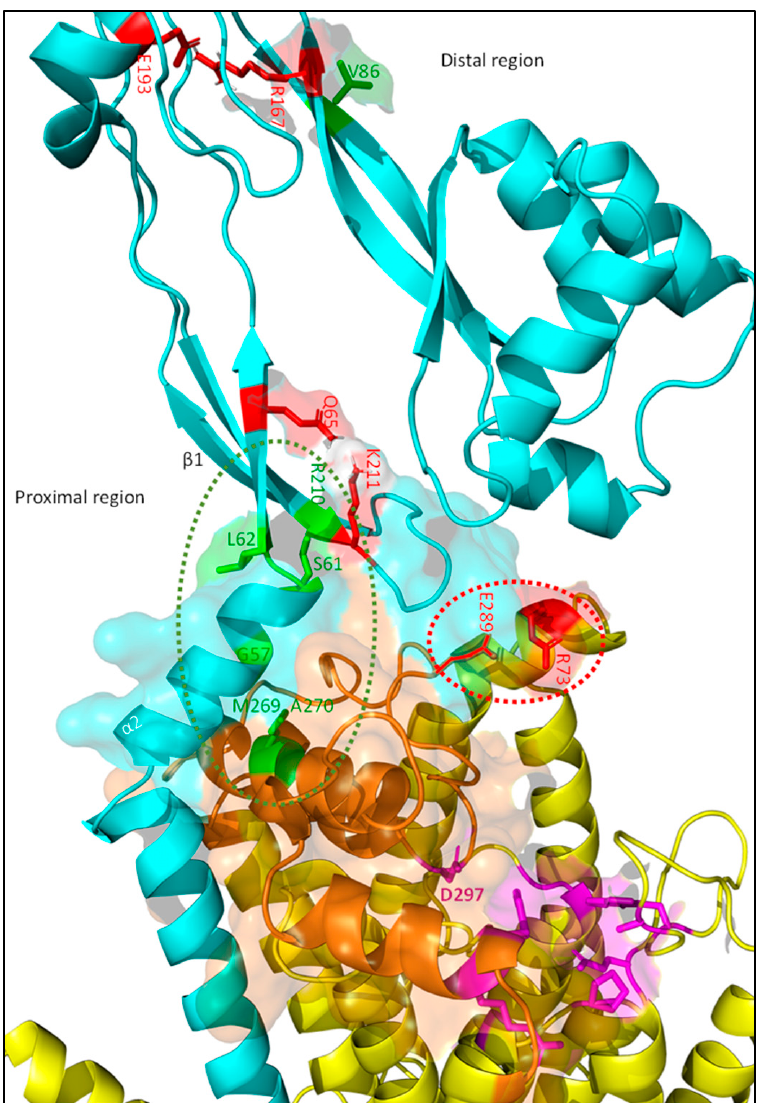
Figure 5. FtsI pedestal domain interaction with FtsW ECL4. FtsI (cyan) and FtsW (yellow) interact in the periplasm leading to the activation of FtsW. The membrane proximal part of the FtsI pedestal domain interacts with ECL4 of FtsW (orange). Activating (green) and suppressing (red) residues can be found in this region, and likely lead to stabilization of the active residue FtsW D297 in the active site. The proximal part of the pedestal domain contains multiple residues divided over an α -helix and β -sheet that activate FtsW. These include residues G57, S61 and L62 located on α 2, and residue R210 on β 1. Residue K211, located adjacent to R210, inhibits FtsW activation, likely through an interaction with Q65. The pedestal domain interacts mostly with the FtsW region around M269, which activates GTase activity. A cluster of residues at the end of the pedestal domain is important for the stability of this domain and appears to be involved in the regulation of the FtsI-mediated activation of FtsW. Residue R167, proposed to interact with E193, stabilizes the domain and thus inhibits FtsW activation, though it may also affect the activity of the FtsI TPase